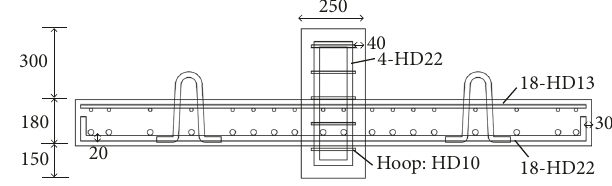
Figure 3: Cross-sectional view of the slab specimen.